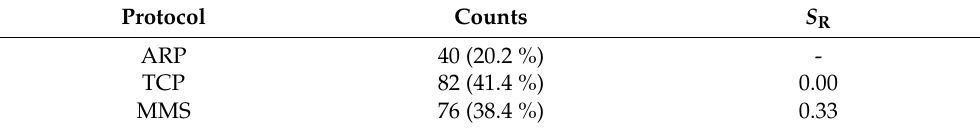
Table 2. Protocol counts and intrusion scores for the corrupted MMS report